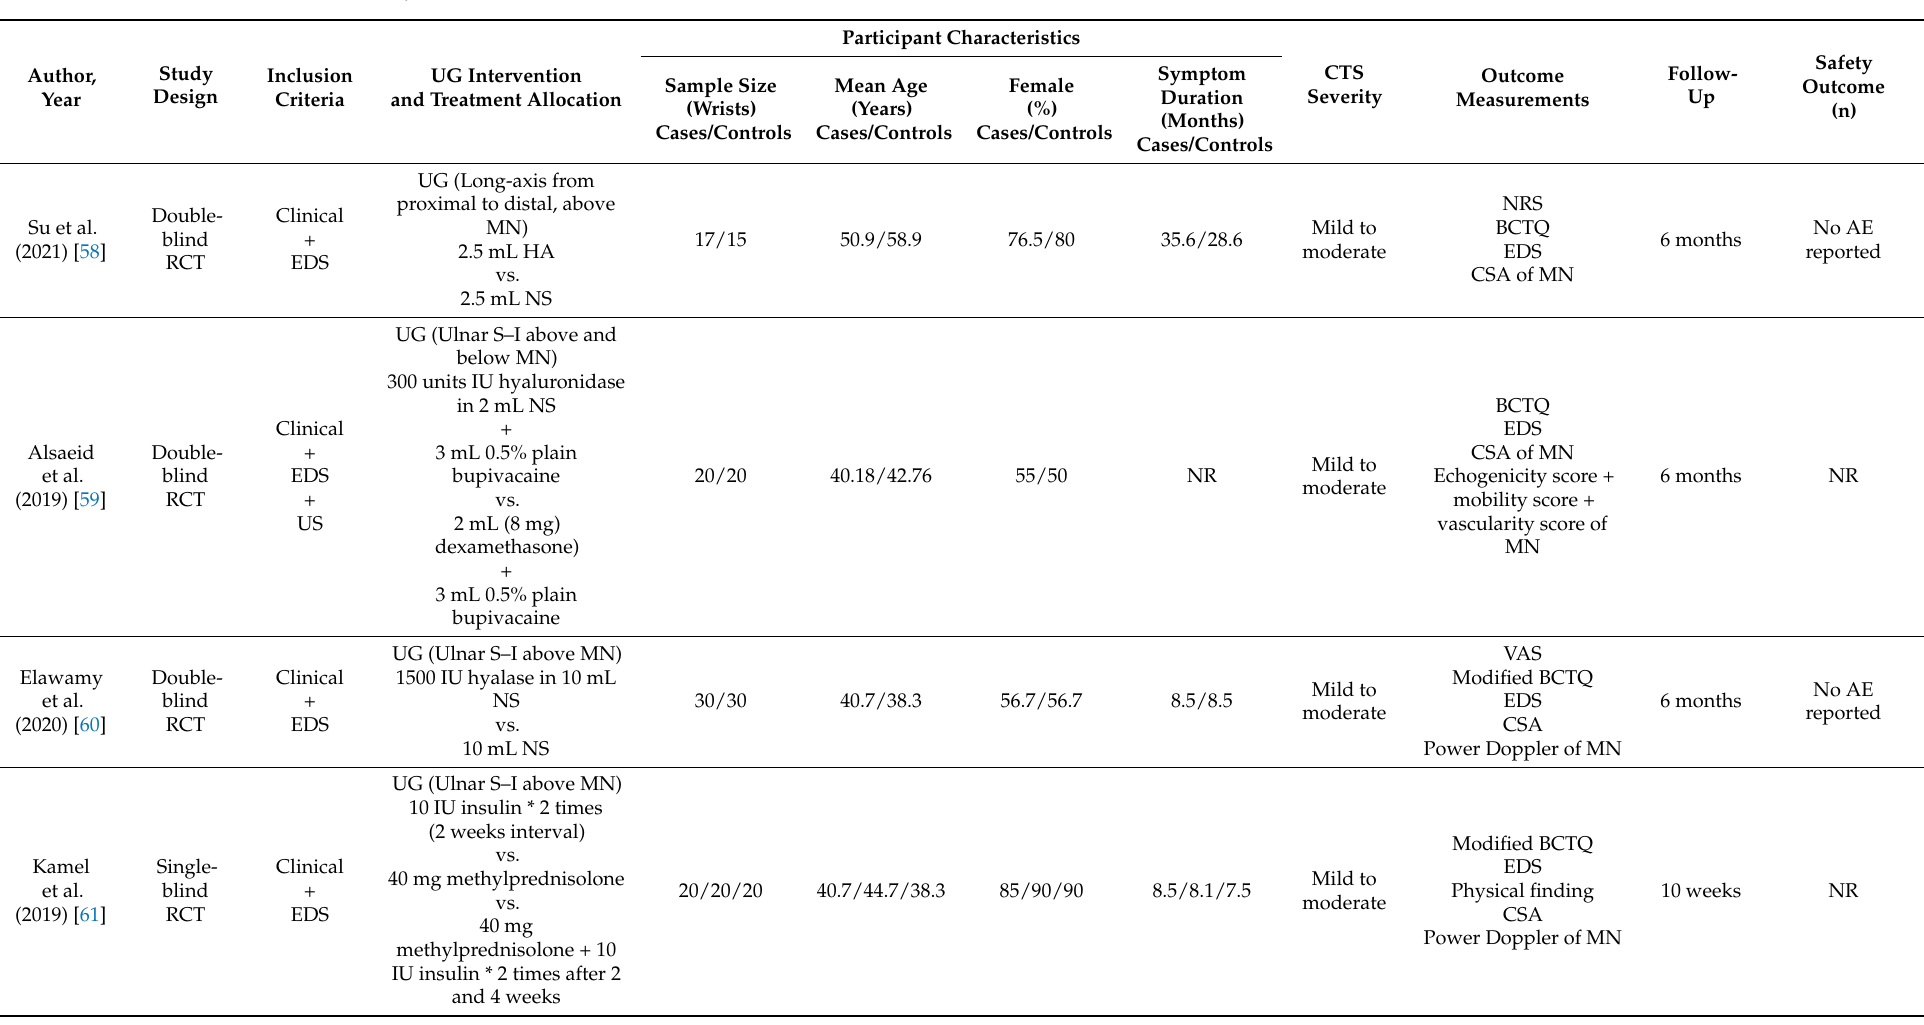
Table 7. Intervention details of included studies using ultrasound-guided hyaluronic acid, hyaluronidase, insulin, and ozone injection for treating carpal tunnel